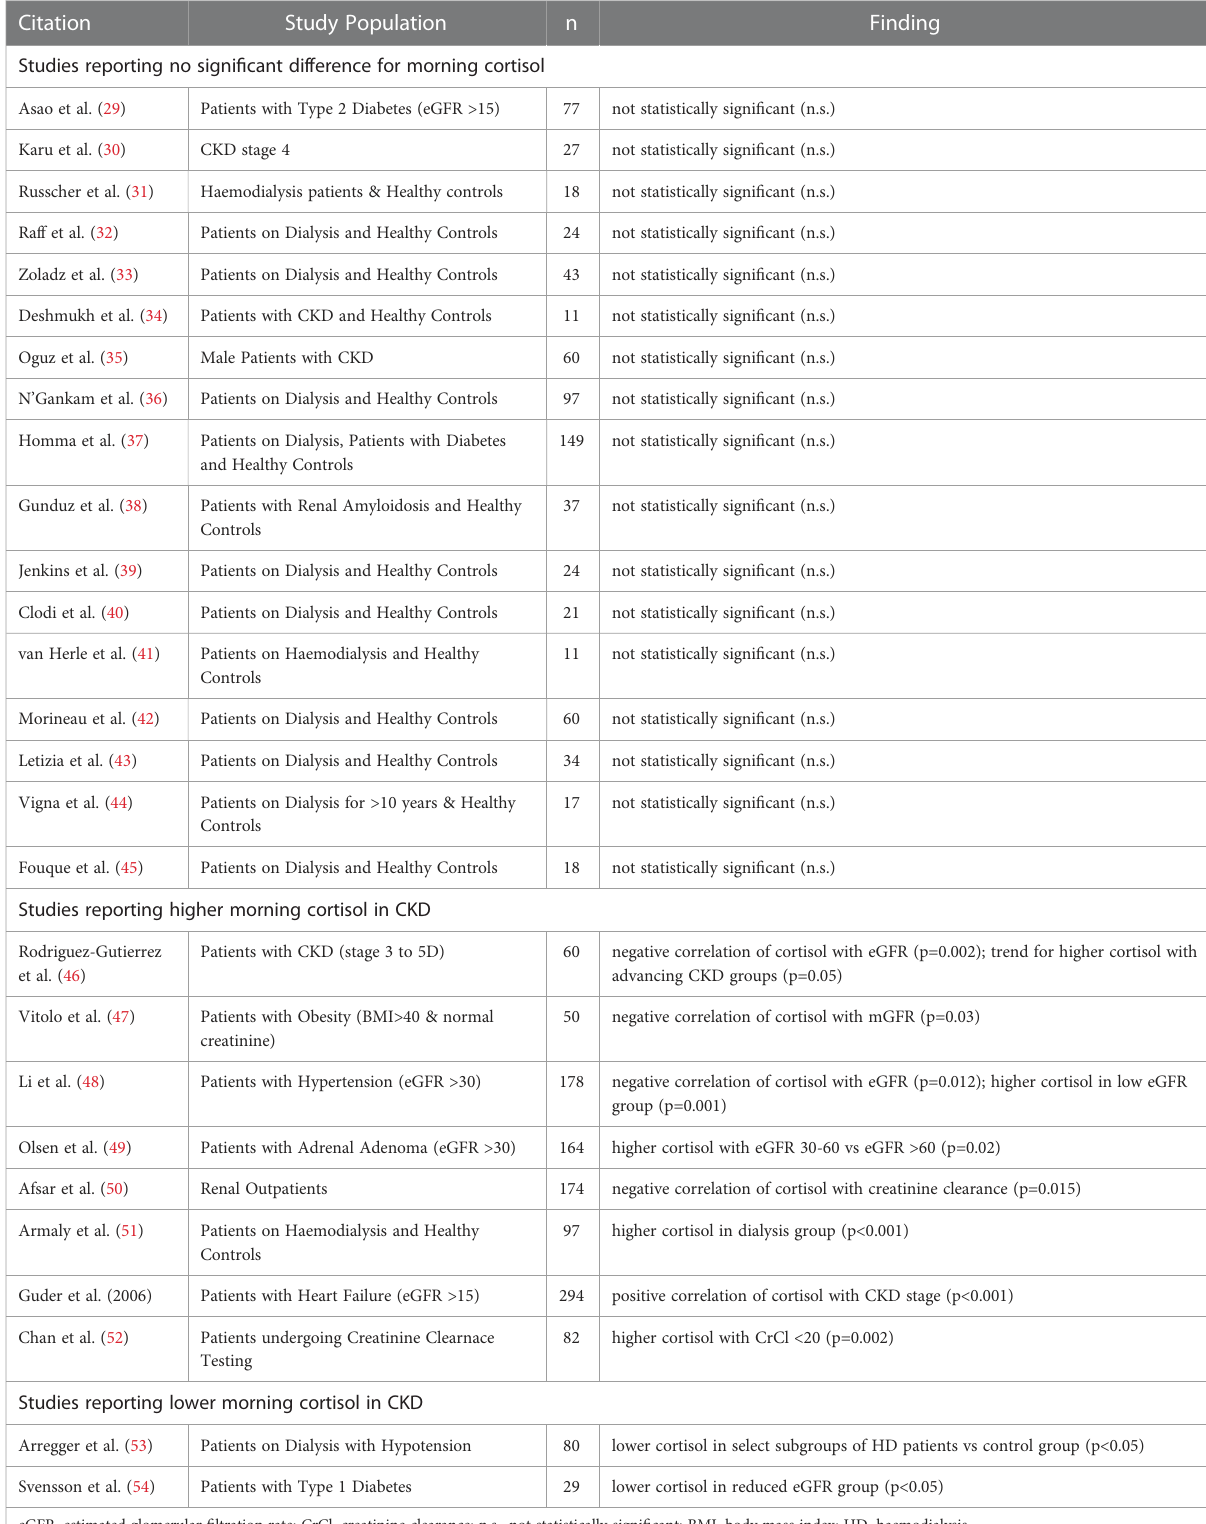
TABLE 1 Morning blood cortisol levels in